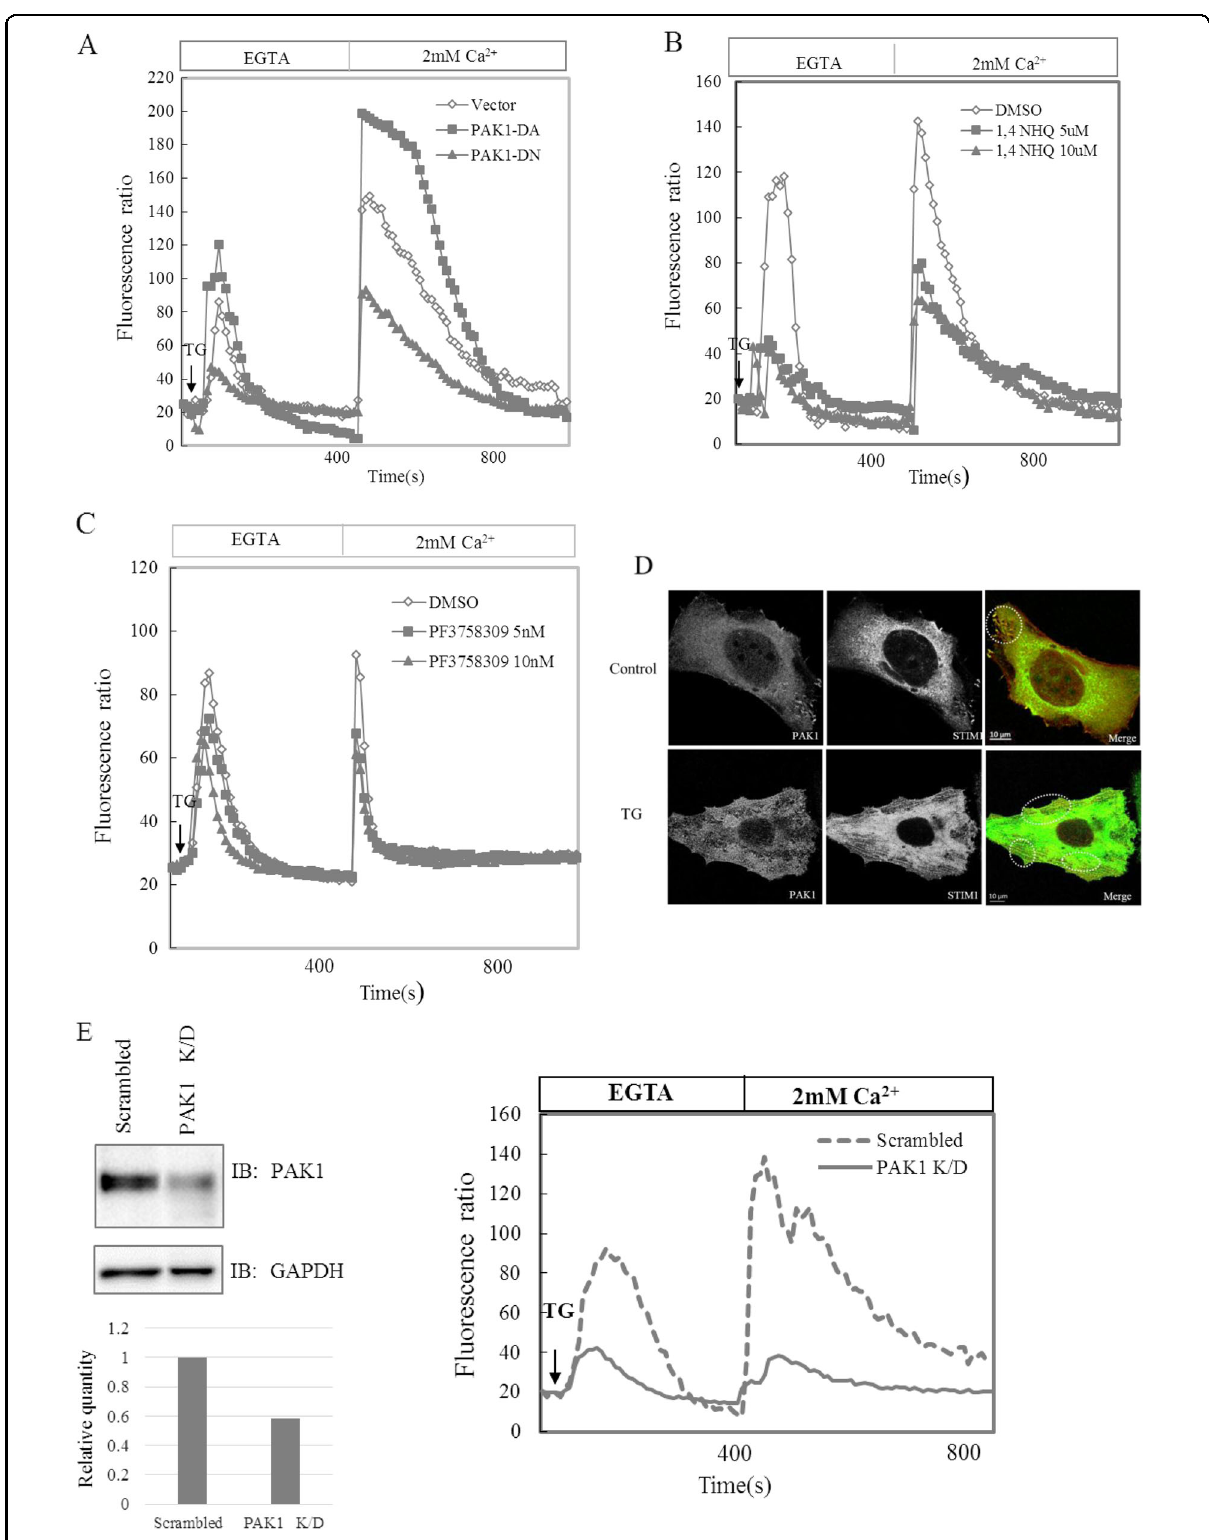
Fig. 3 (See legend on next